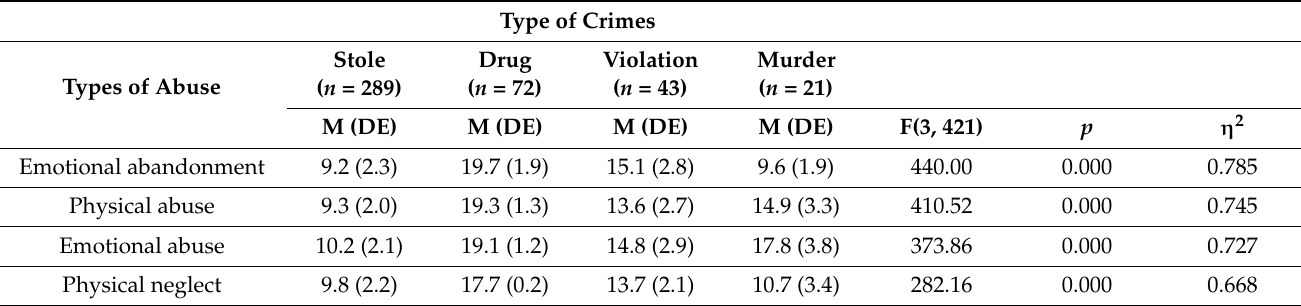
Table 8. ANOVA results for types of child maltreatment and types of crimes. Type of Crimes